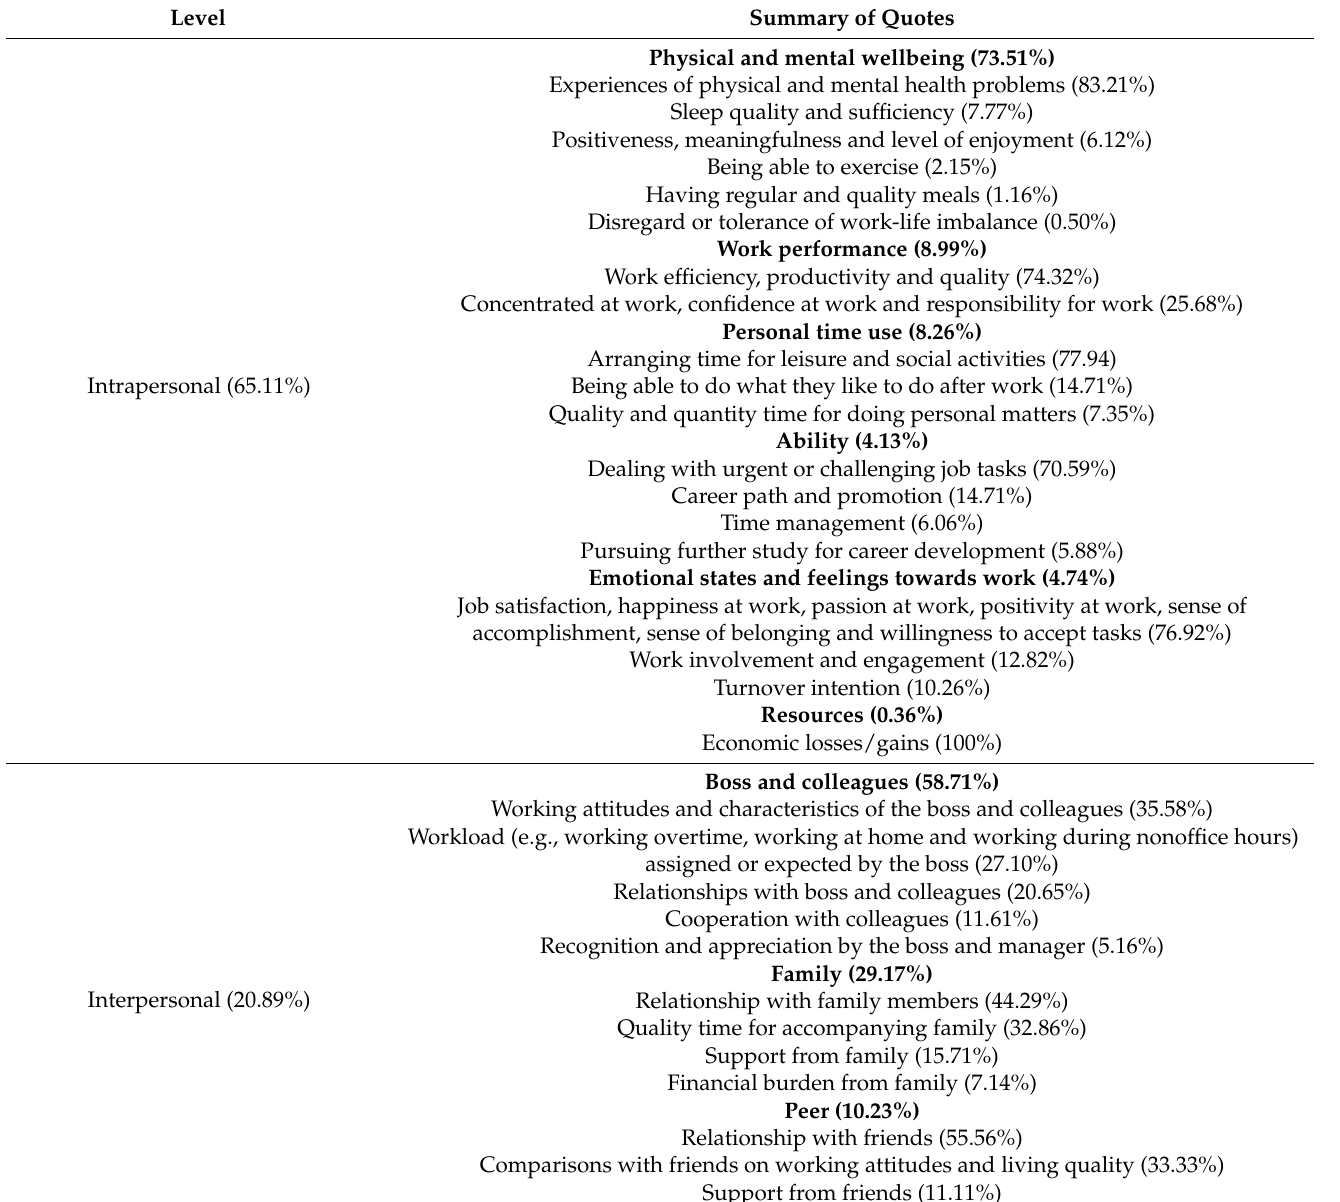
Table 1. Description of socioecological determinants affecting work-life balance (The total number of quotes was 1264.).